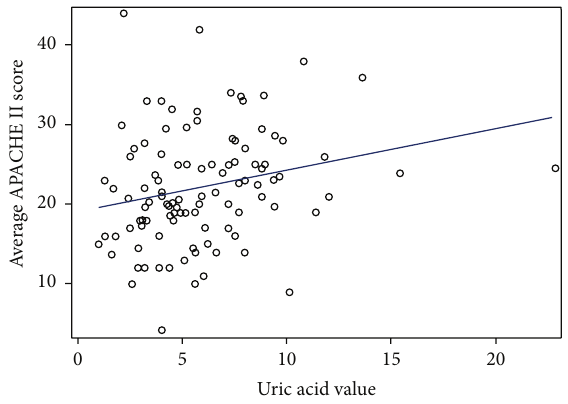
Figure 3: Uric acid levels and APACHE II